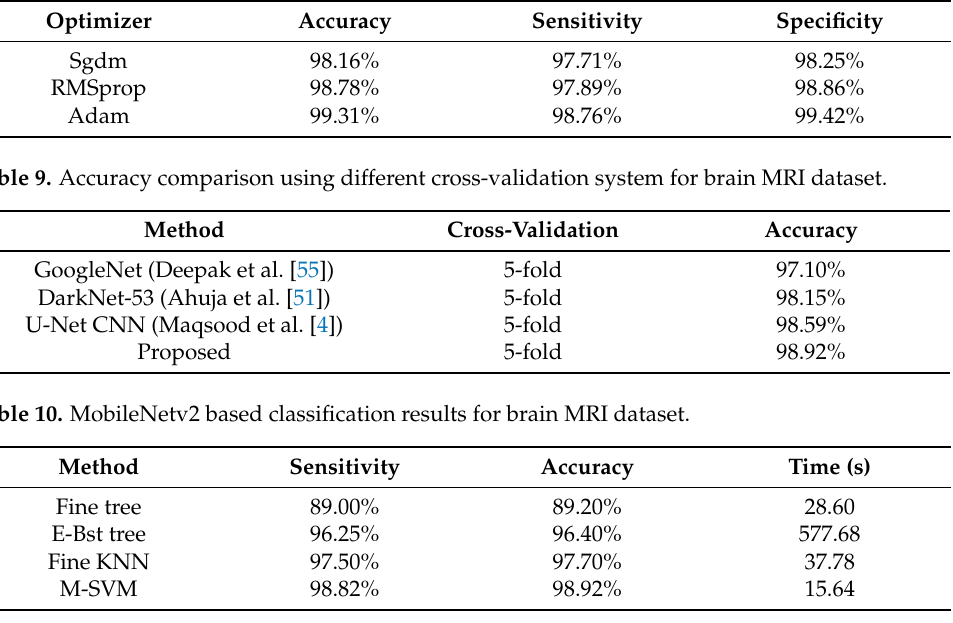
Table 8. Optimizer function’s performance with fine-tuned MobileNetV2 model on brain MRI dataset.